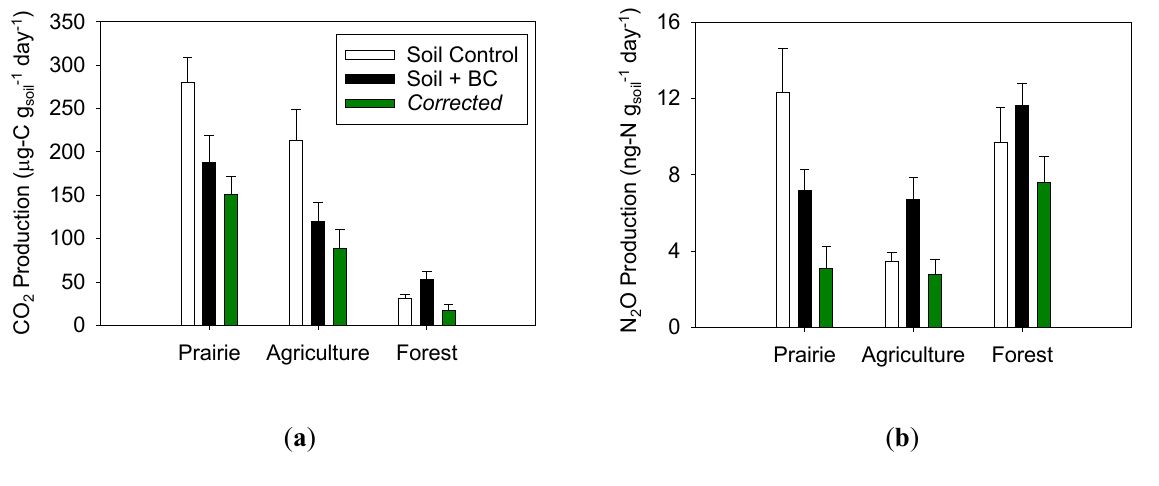
Figure 1. Average ( a ) CO 2 and ( b ) N 2 O production rates observed from the control soils, biochar amended soils, and the mathematically corrected production rates over the entire 30 day incubation period. Rates were calculated from the slope of the change in headspace concentration with time from gas samples taken at various times during the incubation (Section 4.3). The error bars represent one standard